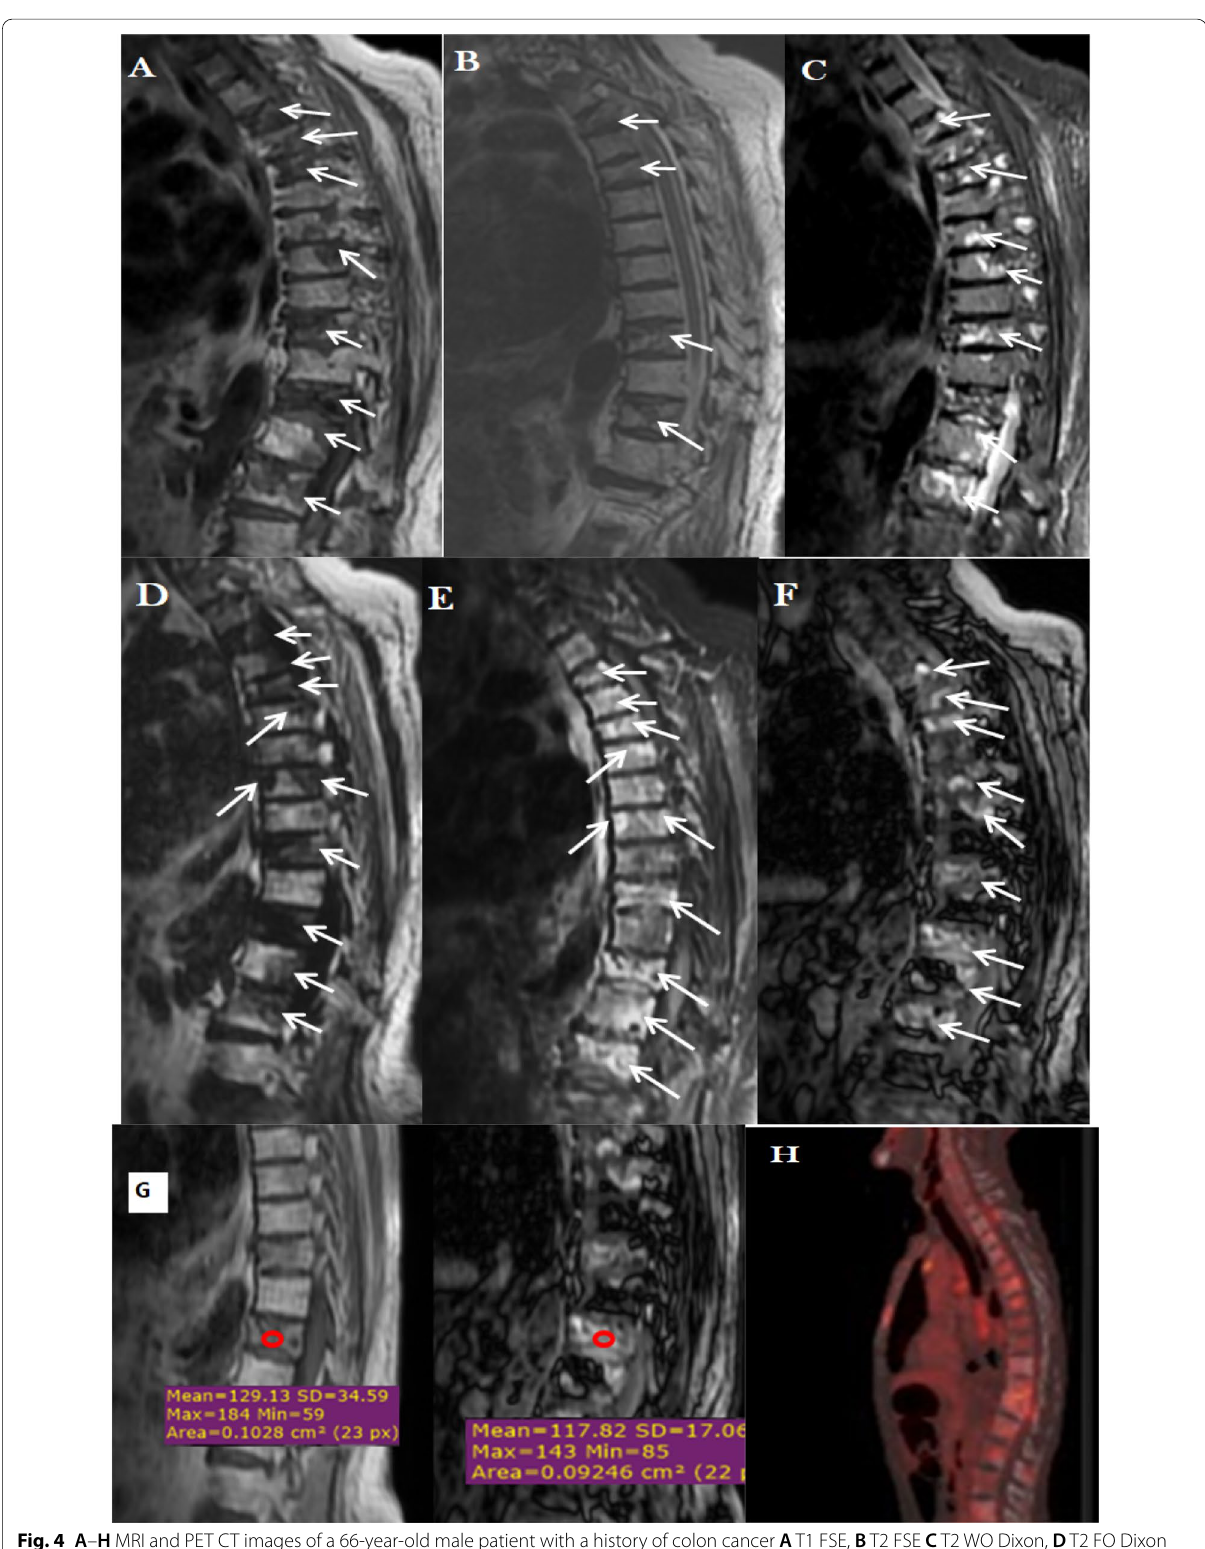
Fig. 4 A – H MRI and PET CT images of a 66-year-old male patient with a history of colon cancer A T1 FSE, B T2 FSE C T2 WO Dixon, D T2 FO Dixon E T1 post-contrast WO Dixon, F T1 post-contrast OP Dixon, G IP/OP ratio MR images and H FDG PET CT show multiple dorsal vertebral metastasis (white arrows) with IP/OP ratio